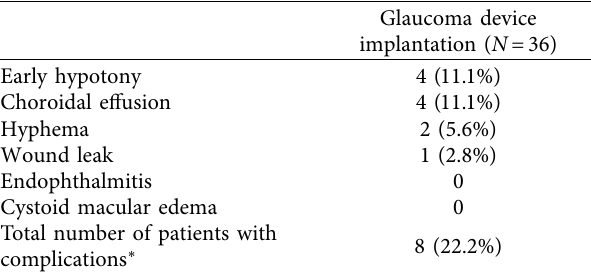
Table 3: Early postoperative complications.